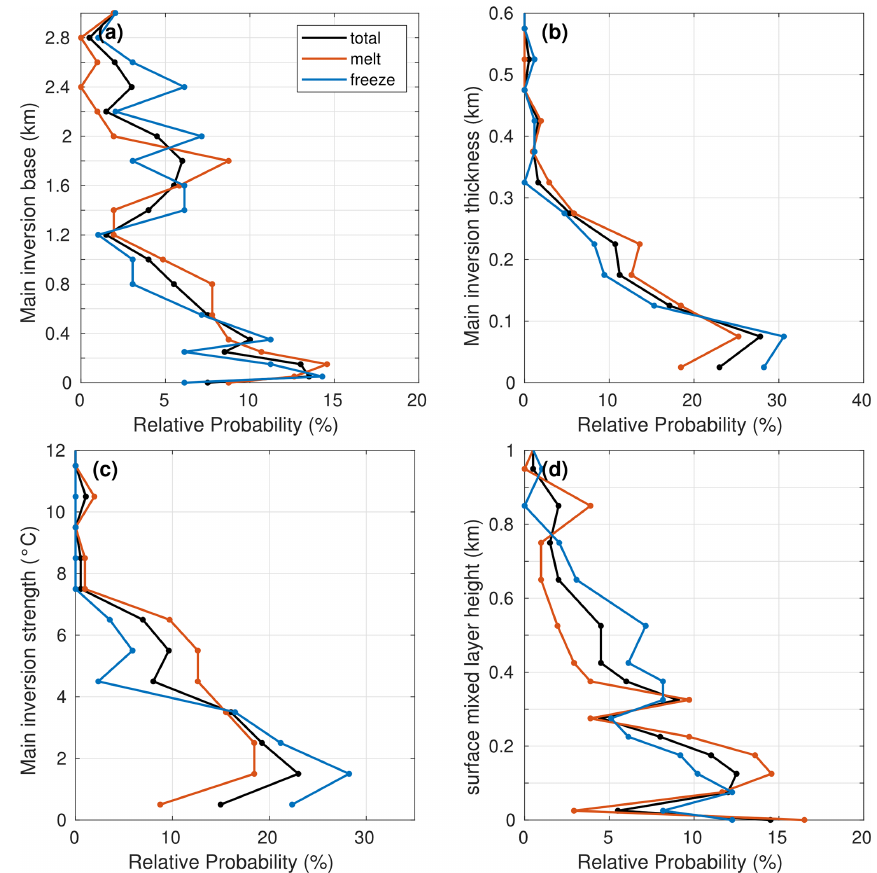
Figure 9. Probability distributions of (a) main capping inversion base, (b) main capping inversion thickness, (c) main capping inversion strength, and (d) SML height, as detected from radiosonde data. Results are shown for the entire campaign (black lines), for the melt period before 28 August (orange lines), and for the freeze period of all data after 28 August (blue